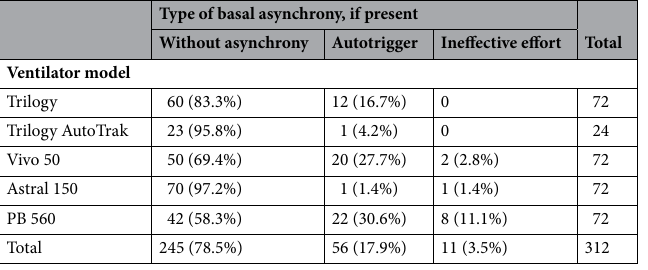
Table 2. Distribution between ventilators of the simulation sequences in which there was baseline asynchrony (p < 0.01 among ventilators, chi-square